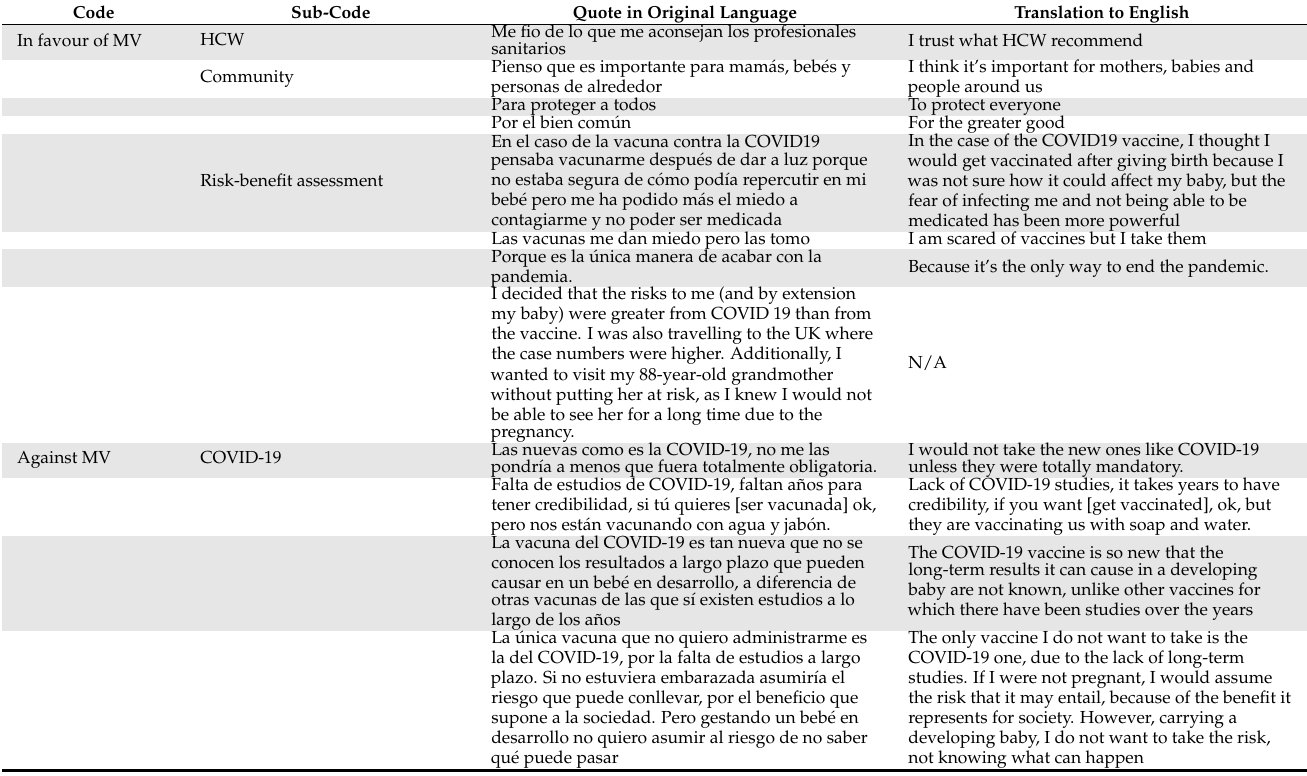
Table A1. Categories for pregnant women’s acceptability of COVID-19